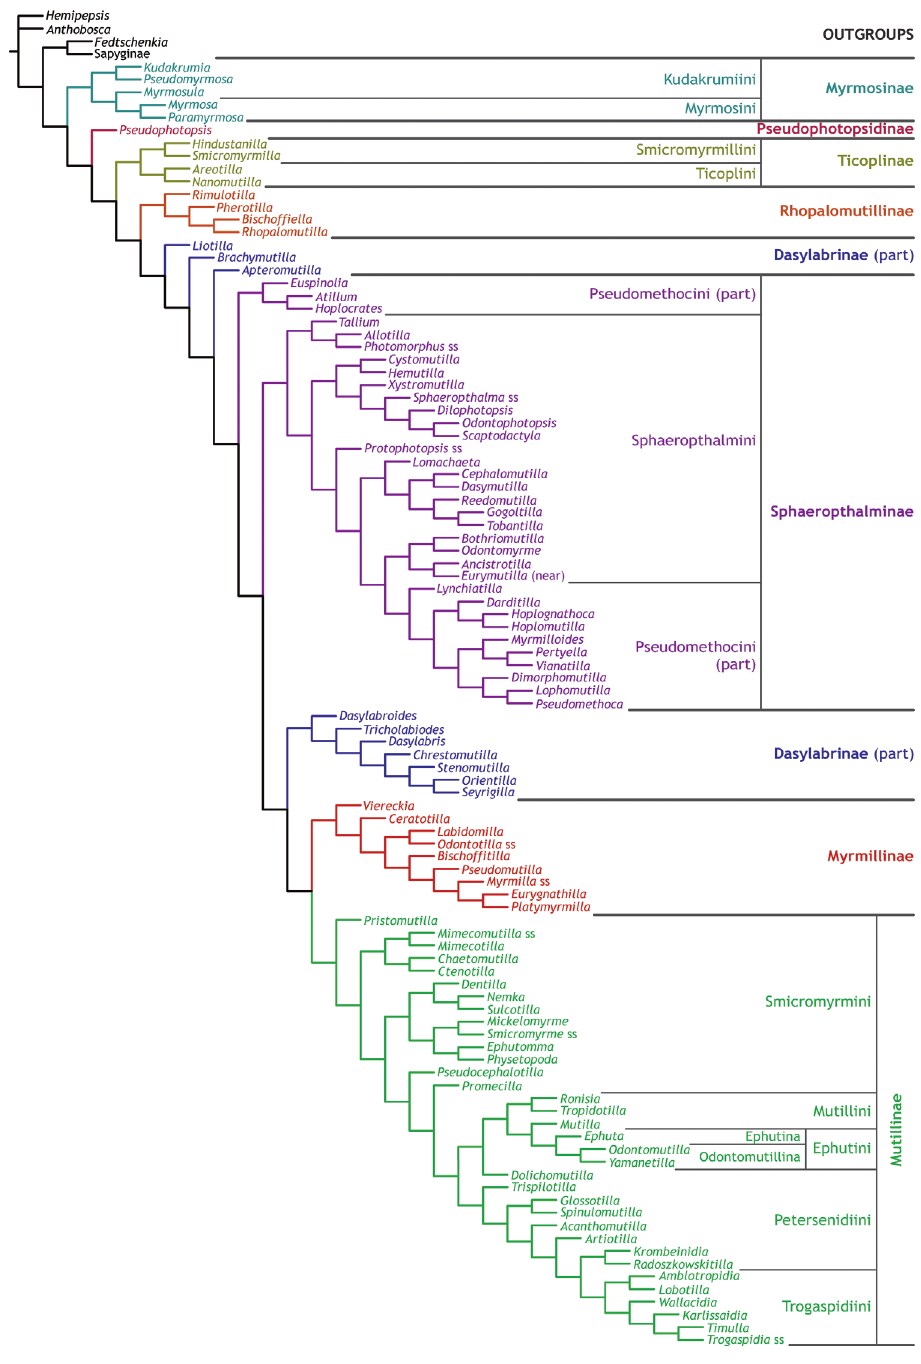
Figure 12. Preferred most-parsimonious tree (see Fig. 5) with potential groups incorporating ideas from both previous classifications